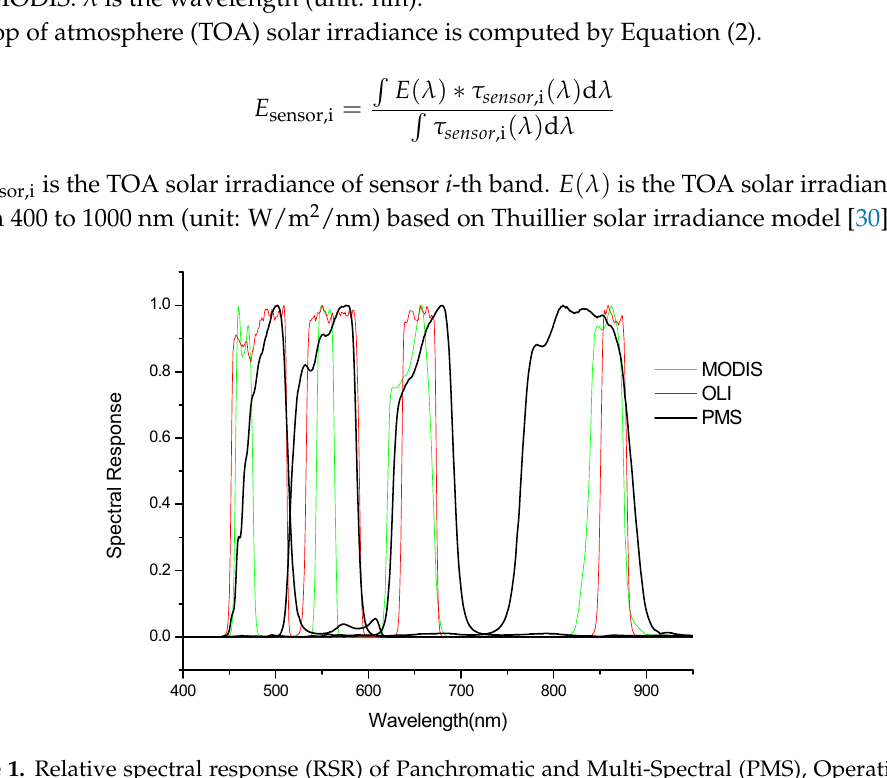
Figure 1. Relative spectral response (RSR) of Panchromatic and Multi-Spectral (PMS), Operational Land Imager (OLI), and MODIS sensor. Table 1. Band number, center wavelength, spectral range, and solar irradiance of PMS, MODIS, and OLI.